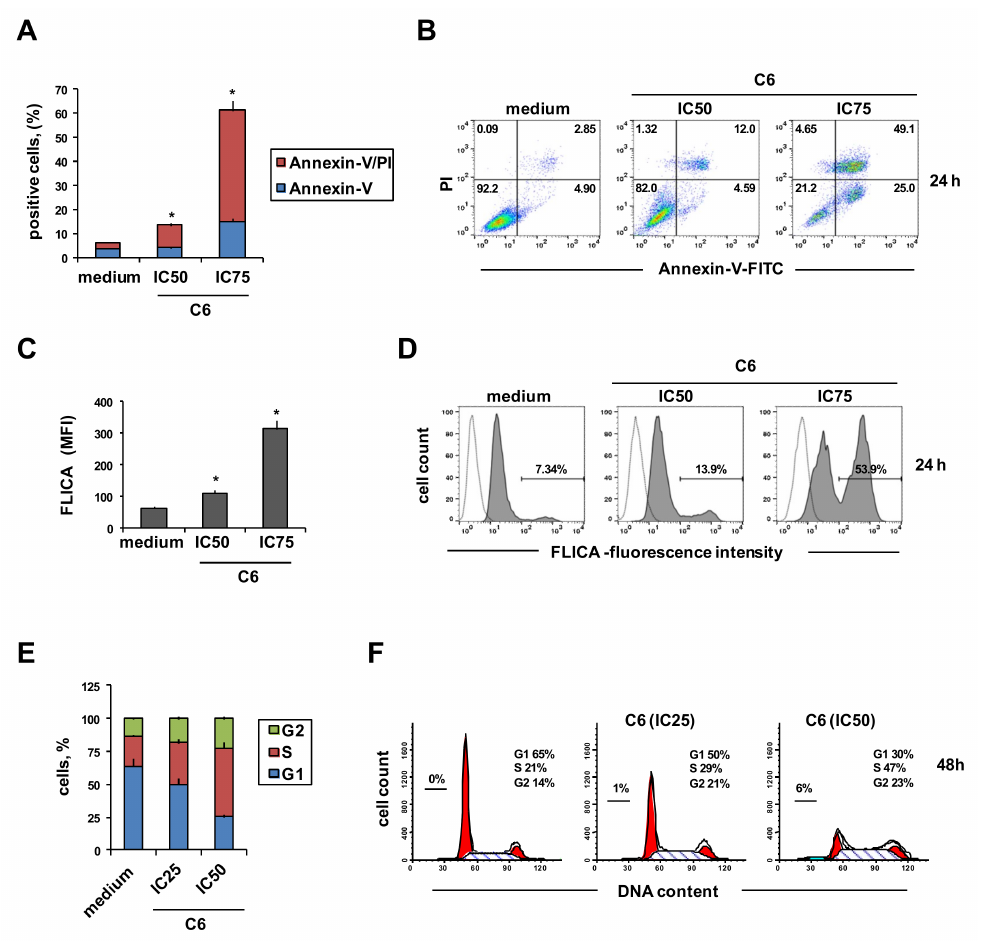
Figure 2. C6 induces apoptosis and blocks the cell cycle. PC3 cells were cultured in complete medium alone or with C6 , at the half-maximal inhibitory concentration (IC 50 ), at IC 25 , or IC 75 , for 24 h. ( A , B ) Annexin-V-FITC and propidium iodide (PI) assay of apoptosis by flow cytometry. ( A ) Percentage of annexin-V-positive cells. ( B ) Representative flow cytometry plots; the percentages of stained cells are reported. ( C , D ) Caspase 3,7 activation assay evaluated using flow cytometry with fluorochrome-labeled inhibitors of caspases (FLICA). ( C ) Mean fluorescence intensity (MFI) of FLICA. ( D ) Representative flow cytometry histograms of caspase 3,7 activation by C6 treatment. The percentage of FLICA-positive cells is reported. ( E , F ) Cell cycle progression determined by PI staining. ( E ) Percentage distribution of cells in different cell cycle phases. ( F ) Representative flow cytometry histograms of cell cycle progression. All bar charts report means and SD of three independent experiments. Statistical analysis was performed using one-way ANOVA, followed by Dunnett’s multiple comparisons test. * p < 0.05 vs.